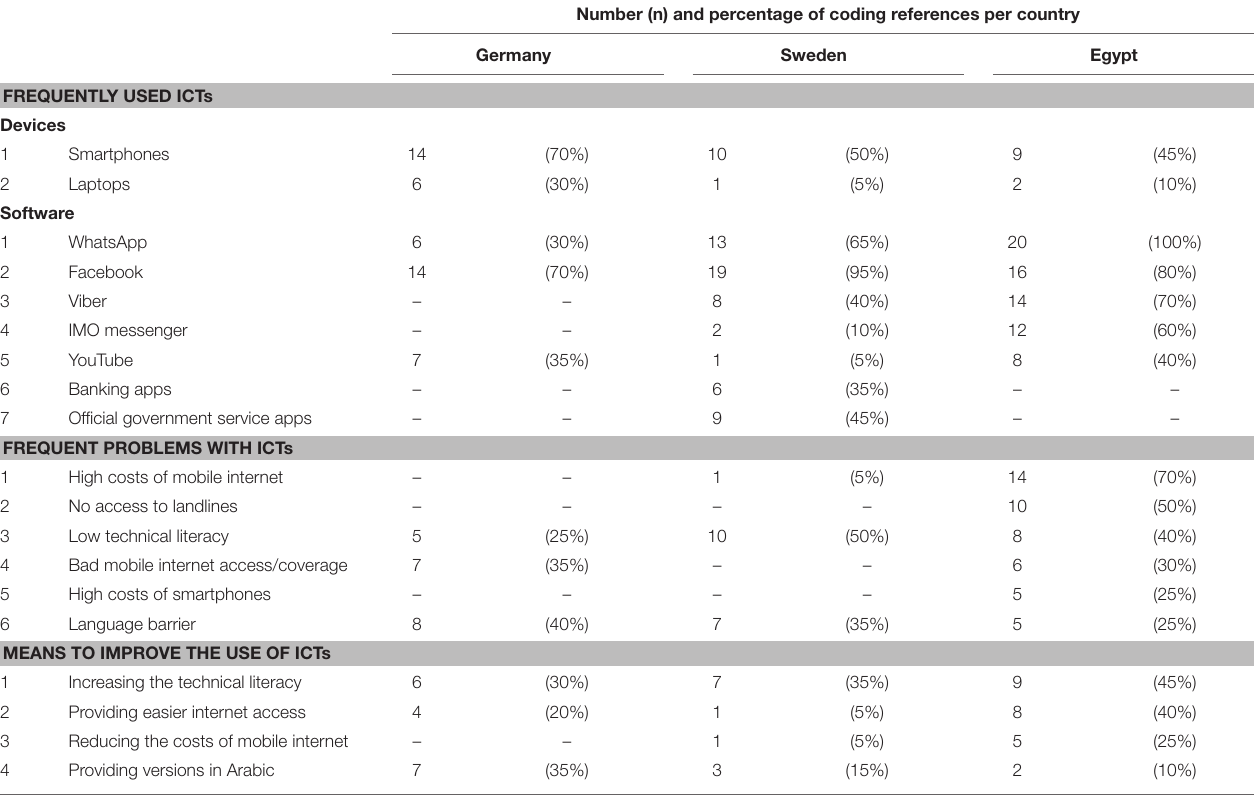
TABLE 2 | Results on the use of Information and Communication Technologies (ICTs) found in free list interviews in Germany, Sweden and Egypt (each N = 20). Number (n) and percentage of coding references per country